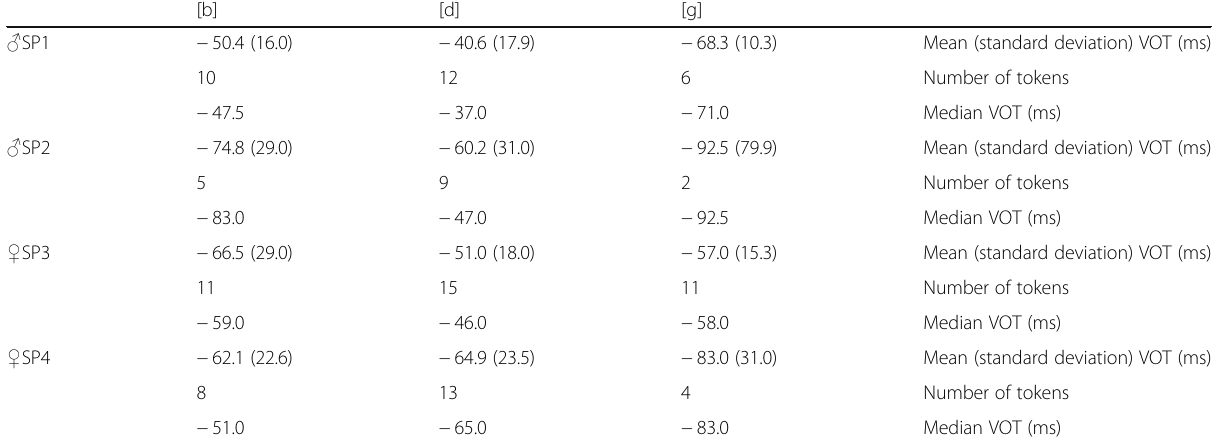
Table 4 Mean (standard deviation) VOT values, number of tokens and median